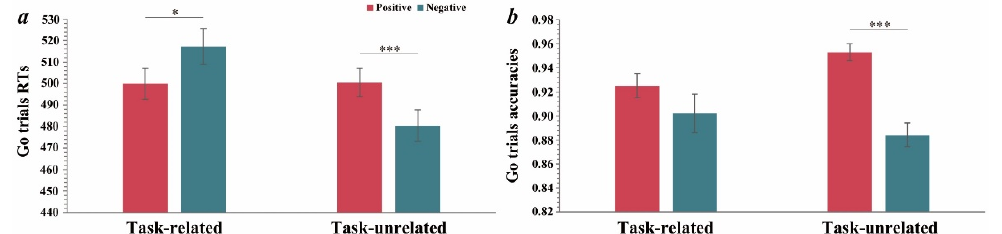
Figure 3. ( a ) Task × valence interaction on go trials RTs. ( b ) Task × valence interaction on go trials accuracies. The error bars stand for the standard deviation of the means. * p < 0.05, *** p < 0.001.